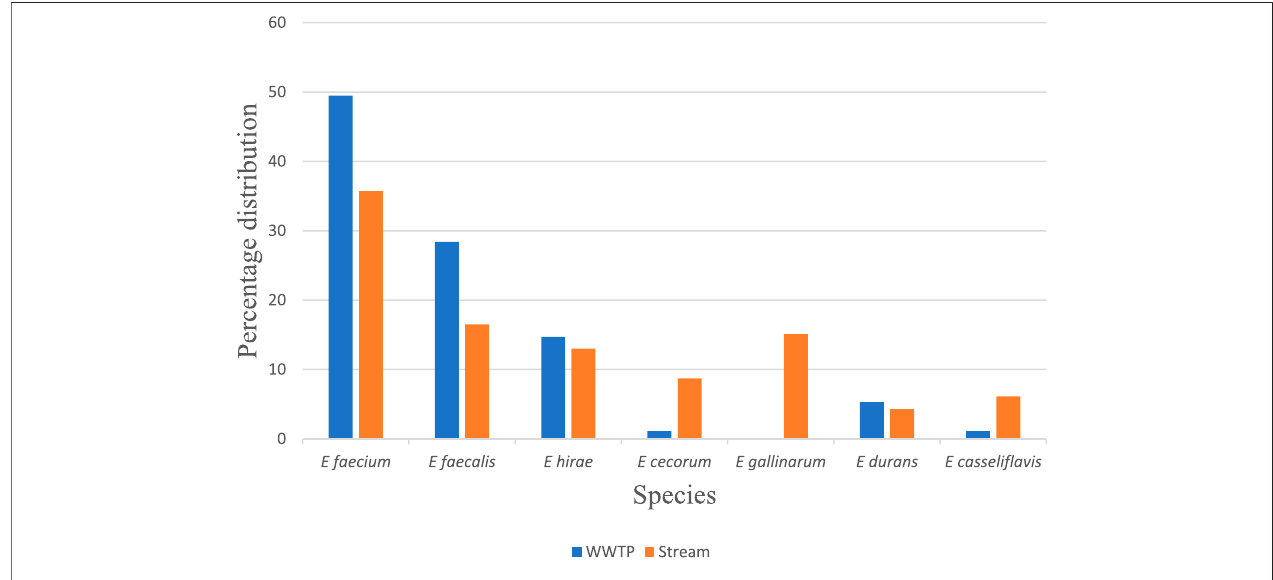
FIGURE 2 | Percentage distribution of the Enterococcus species among the isolates.